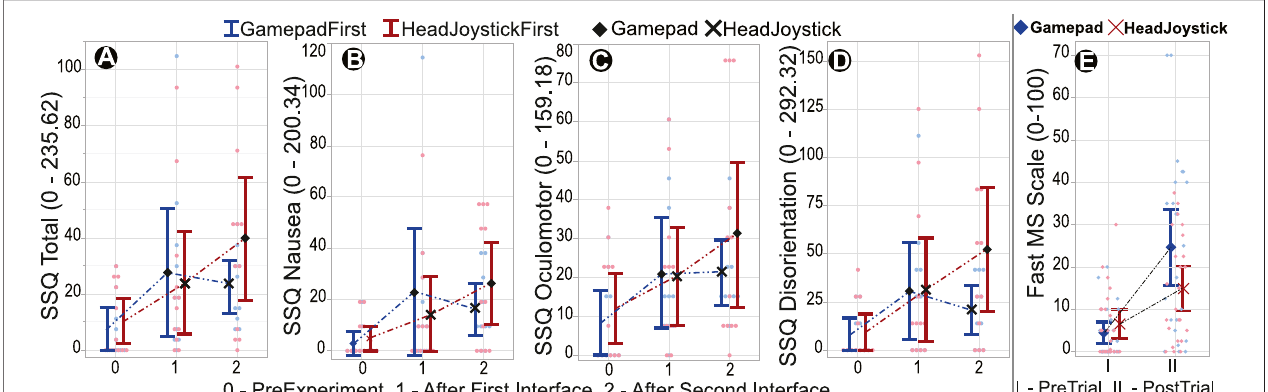
Figure 7A . ANOVA revealed a main effect of time (Pre- Figure 7B . ANOVA revealed a main effect of time, Experiment, after the fi rst interface, and after the second (cid:2) . 221. However, there was no F ( 1 . 79 , 35 . 8 ) (cid:2) 5 . 67 , p (cid:2) . 007 , η 2 interface), F (cid:1) 1 . 85 , 36 . 9 (cid:3) (cid:2) 8 . 05 , p (cid:2) . 001 , η 2 p (cid:2) . 287. There was p no effect of group (GamepadFirst/HeadJoystickFirst), F ( 1 , 20 ) (cid:2) effect of group, F ( 1 , 20 ) (cid:2) . 031 , p (cid:2) . 861 , η 2 p (cid:2) . 002 as well as no (cid:2) . 022 as well as no interaction between time × . 457 , p (cid:2) . 507 , η 2 interaction between time × group p (cid:2) . 065. LSMeans contrast F ( 1 . 79 , 35 . 8 ) (cid:2) 1 . 40 , p (cid:2) . 260 , η 2 group F ( 1 . 85 , 36 . 9 ) (cid:2) 1 . 71 , p (cid:2) . 197 , η 2 p (cid:2) . 079. LSMeans (Least p showed that in the GamepadFirst group, the nausea score increased signi fi cantly from Pre-Experiment ( M (cid:2) 2.86, SD (cid:2) 6.44) to Gamepad use ( M (cid:2) 22.9, SD (cid:2) 34.6), F (1, 40) (cid:2) 5.91, p (cid:2) 0.020. However, switching to HeadJoystick as the second interface reduced nausea scores ( M (cid:2) 16.2, SD (cid:2) 14.3) and they were no longer signi fi cantly higher than the Pre-Experiment scores (blue line in Figure 7B ). Similarly, for the HeadJoystickFirst group, nausea scores after their fi rst trial with the HeadJoystick ( M (cid:2) 14.3, SD (cid:2) 23.2) were not signi fi cantly elevated compared to their Pre-Experiment nausea scores ( M (cid:2) 4.77, SD (cid:2) 7.6). When they switched from HeadJoystick to Gamepad, their nausea score increased ( M (cid:2) 26.2, SD (cid:2) 25.1) and were signi fi cantly higher than their Pre- Experiment scores (red line in Figure 7B ).